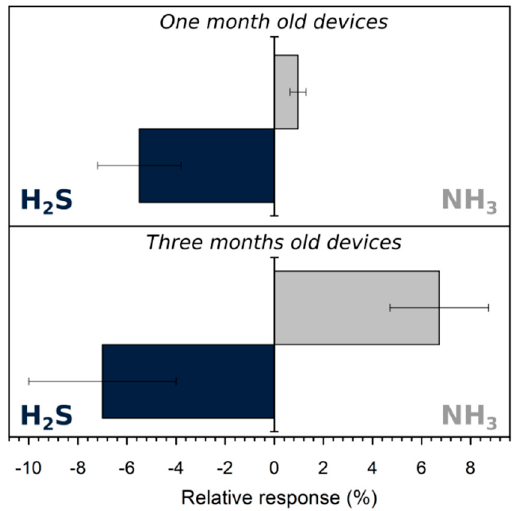
Figure 9. Relative response of devices one ( up ) and three ( down ) months old to 574 ± 5 ppb of H 2 S (left and blue) and NH 3 (right and grey).